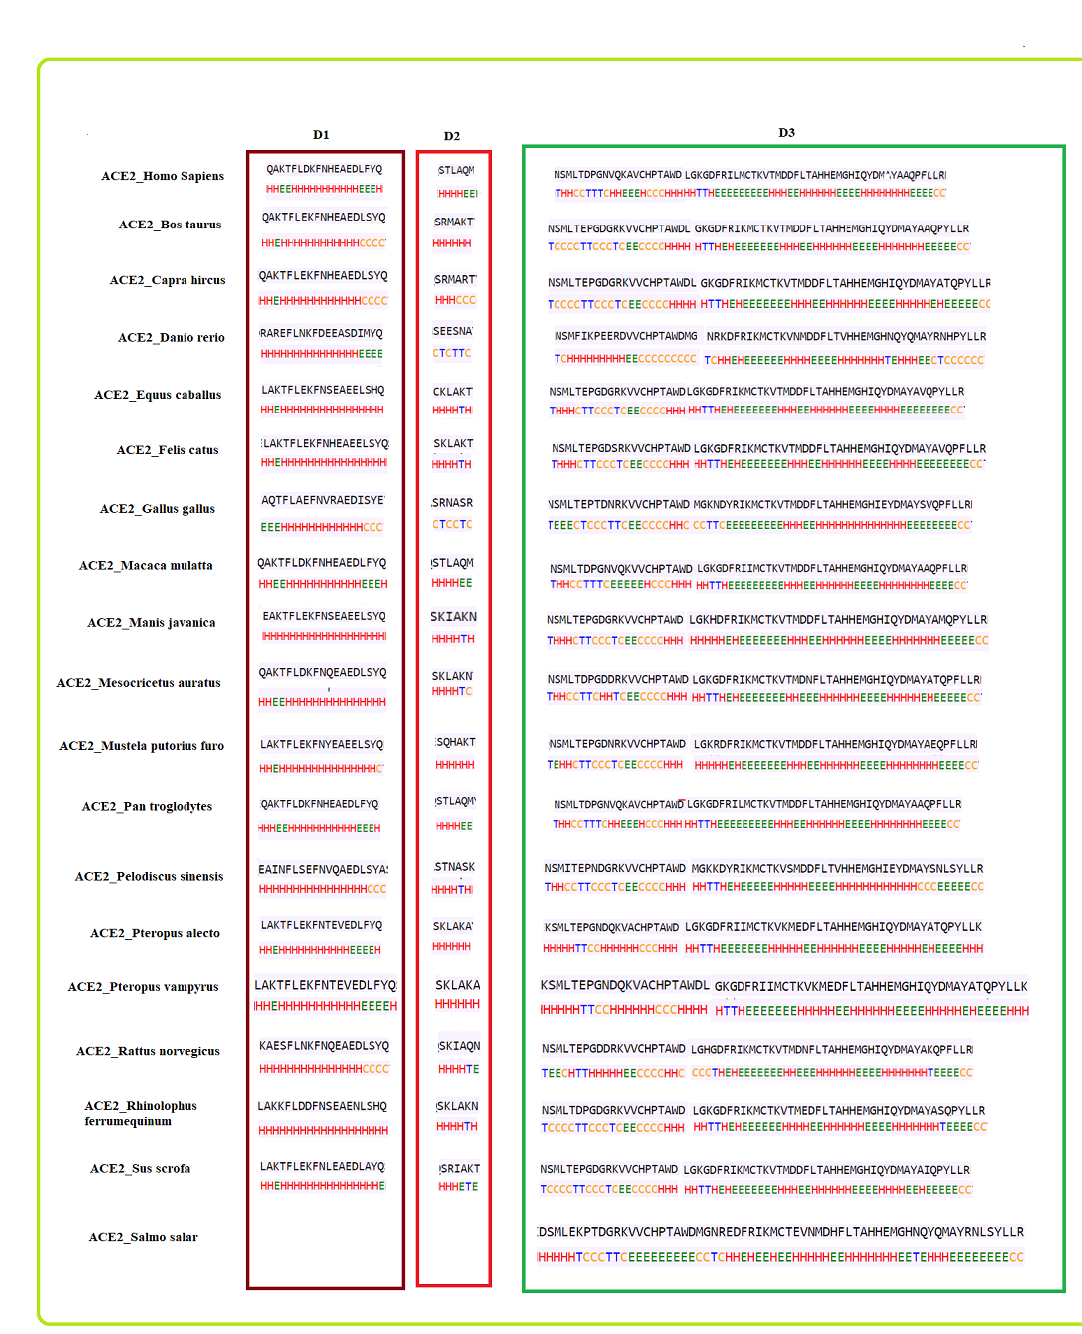
Figure 4. Predicted secondary structures of D1, D2, and D3 domains for 18 species and only D3 domain for Salmo salar